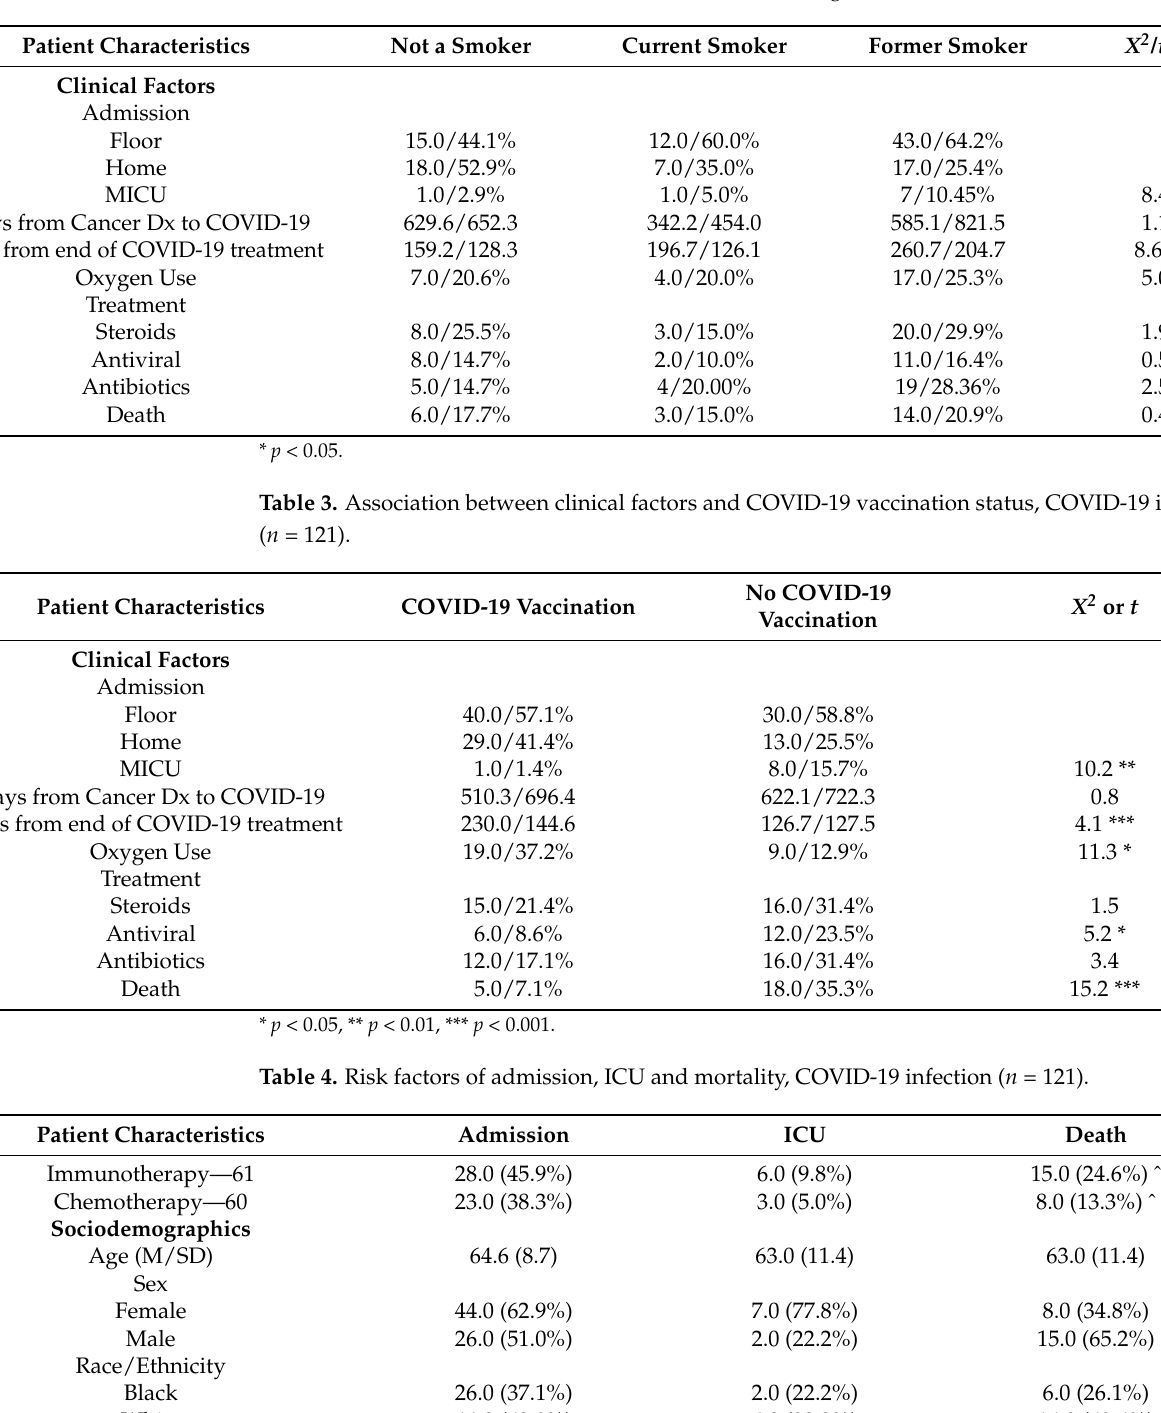
Table 2. Associations between clinical factors and smoking status, COVID-19 infection ( n = 121).